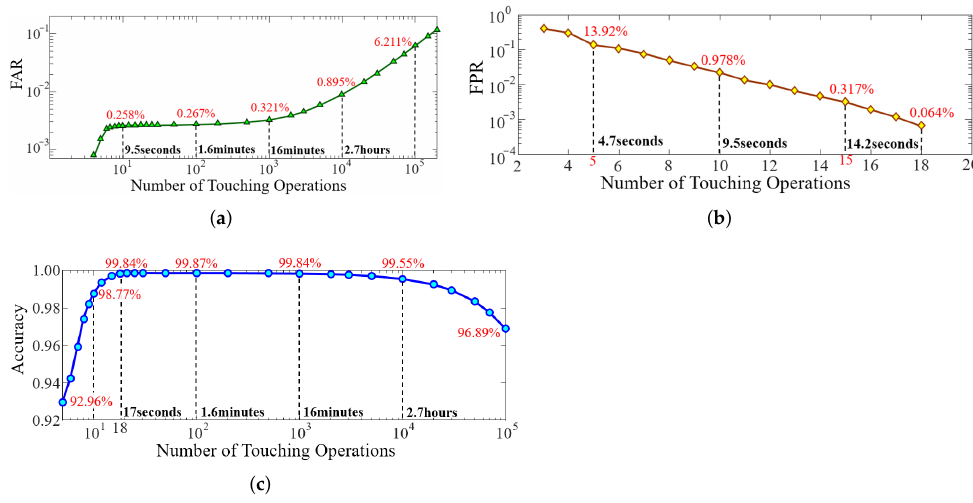
Figure 11. System performance of BioTouch during usage. ( a ) False Alarm Rate (FAR) for legitimate users. ( b ) False Positive Rate (FPR) for attackers. ( c ) System accuracy of